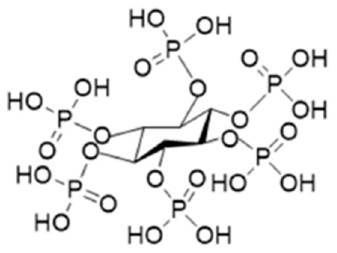
Figure 1. Chemical structure of phytic acid.